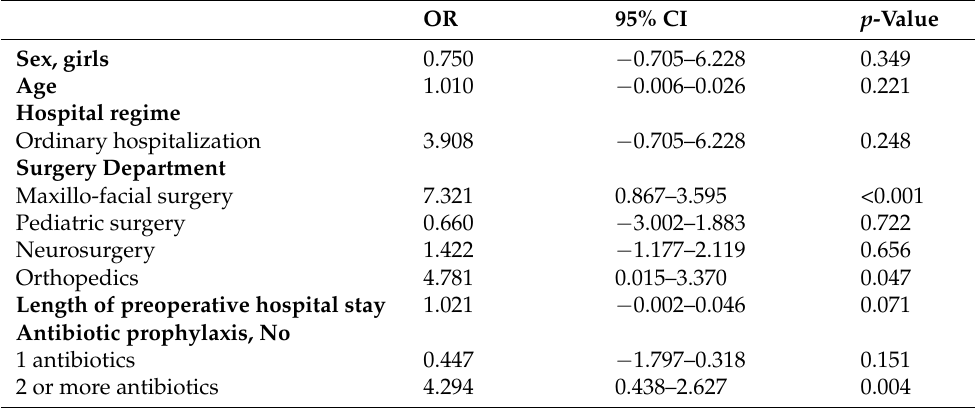
Table 2. Associations between SSIs and the risk factors in surgery patients.